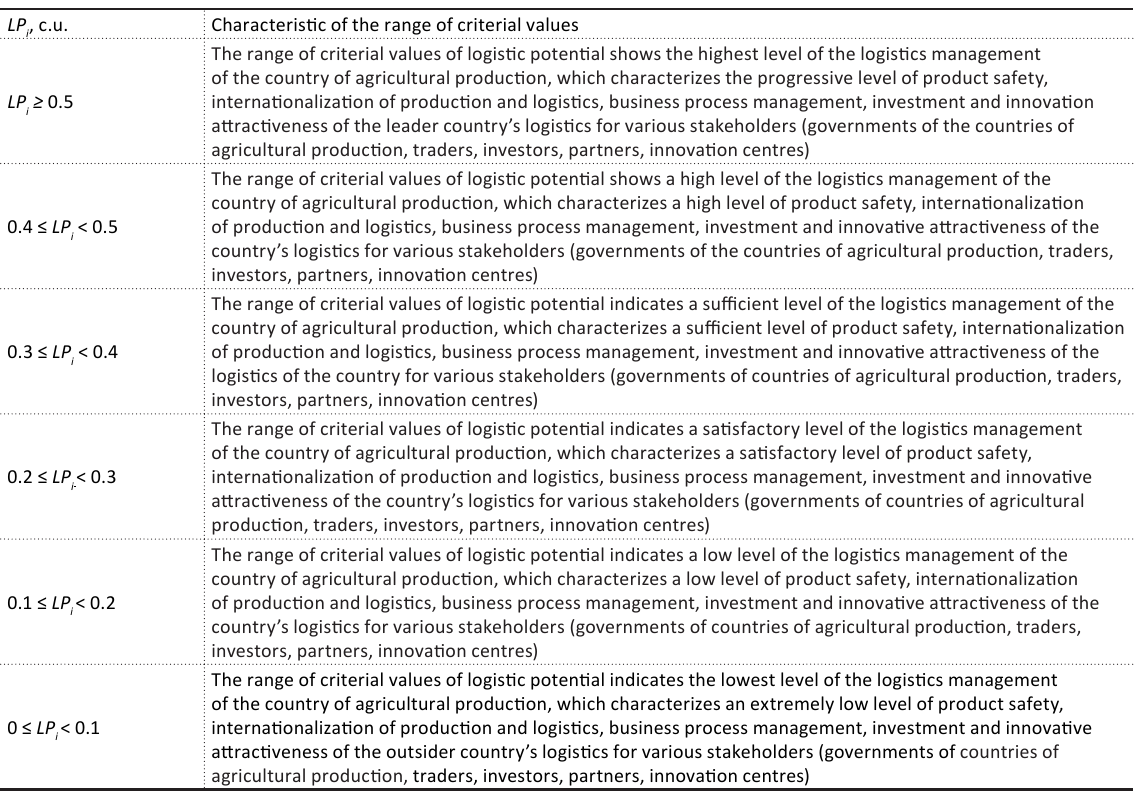
Table 3. Criteria of logistic potential of countries across the world LP , i